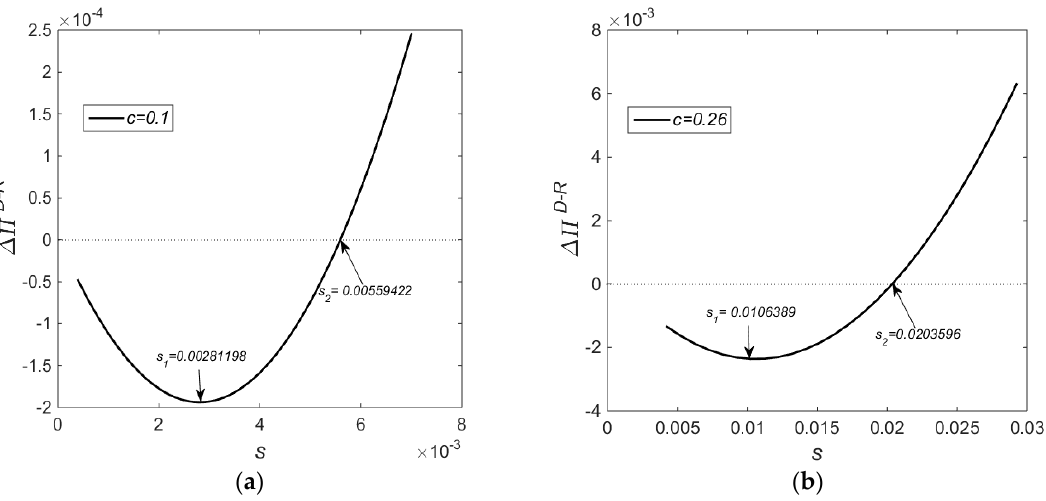
Figure 1. Impact on the Profit Difference from Two Subsidy Models for Different Subsidy Levels; ( a ) =0.1 c , ( b ) 0.26 c = .